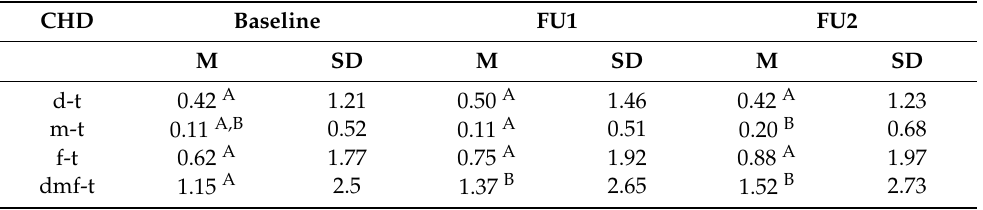
Table 1. Dmf-t values of the CHD group: decayed (d), filled (f) and missing (m) deciduous teeth (t). Mean values (M) including standard deviation (SD) at baseline and after the two follow-ups (FU1 and FU2). CHD Baseline FU1 FU2 M SD M SD M SD d-t 0.42 A 1.21 0.50 A 1.46 0.42 A